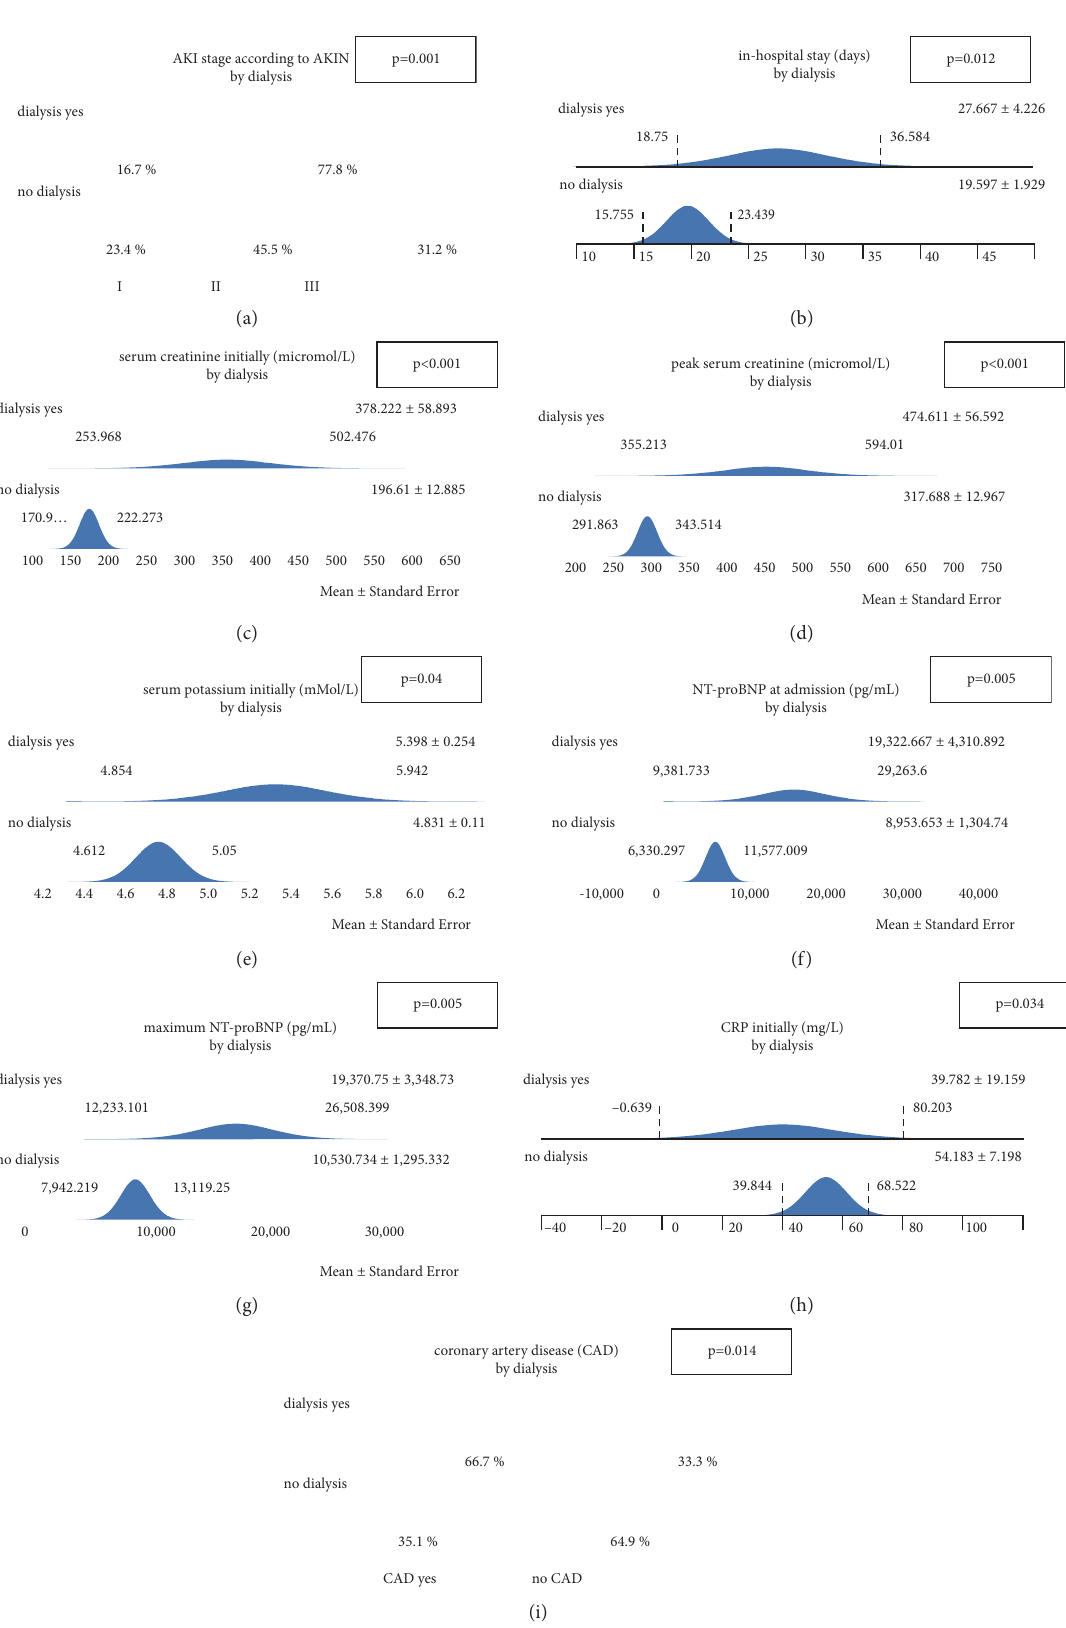
Figure 2: Several variables significantly differed between subjects with versus without the need for dialysis therapy (‘dialysis yes’ versus ‘no dialysis’). (a) AKI stage 3 more prevalent in ‘dialysis yes.’ (b) In-hospital stay (longer in ‘dialysis yes’). (c), (d) Initial and peak creatinine higher in ‘dialysis yes.’ (e) Initial serum potassium higher in ‘dialysis yes.’ (f), (g) Initial and maximum NT-proBNP higher in ‘dialysis yes.’ (h) Initial CRP higher in ‘no dialysis.’ (i) Coronary artery disease more prevalent in ‘dialysis yes’ (data are represented as mean+/ −